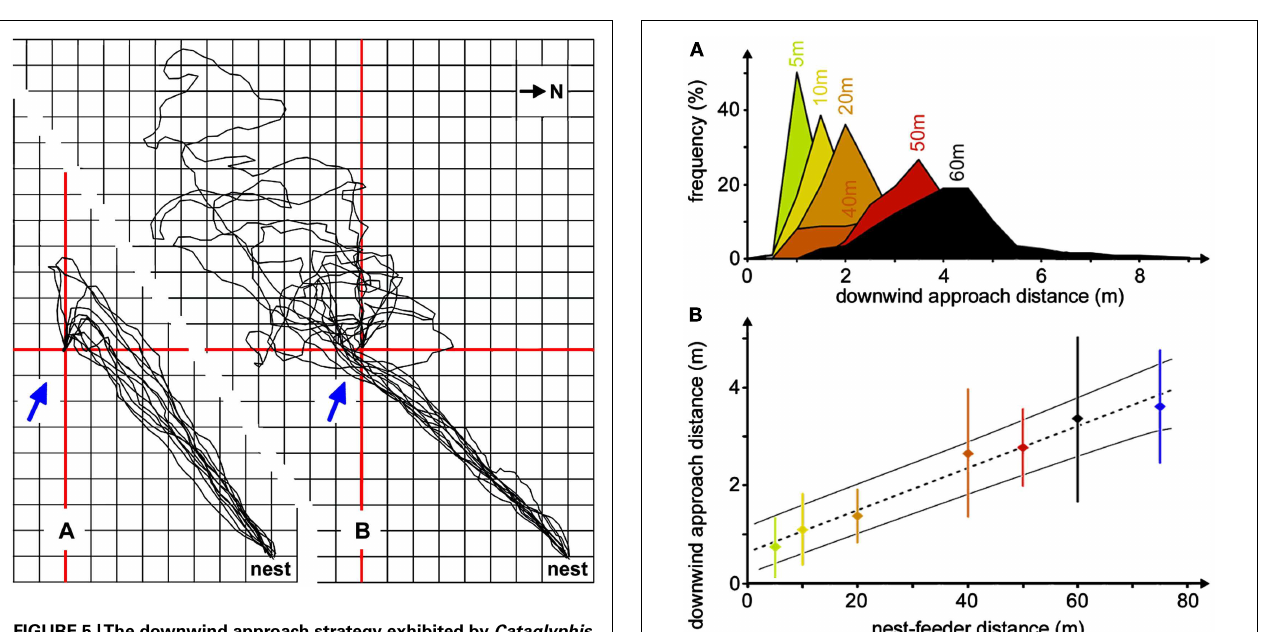
FIGURE 5 |The downwind approach strategy exhibited by Cataglyphis ants reduces the average foraging path length. Typical downwind approaches of four foragers are shown in (A) , the final upwind segments guided by the odor traces emanating from the small and inconspicuous feeder (see Figure 1A ). Feeder position is marked by red cross lines; grid line distance is 0.5m. Ambient wind direction is indicated by blue arrows. The downwind approach afforded an additional 1.6m walking distance compared to a beeline approach, on average. (B) The same ants occasionally choose a slightly different path, probably due to lack of experience and slight shifts in wind direction (Wolf, 2008). Approaches of the same four animals, performed just before or after the sample runs shown in (A) and leading into an area upwind of the food source, are superimposed in (B) .They demonstrate that the ants missed the feeder by passing upwind of the odor traces and illustrate the ensuing searches of an average 9.7m walking distance, in addition to the direct approach distance of about 5.7m. Compass north is indicated in the top right corner; nest-feeder distance is 5.7m.